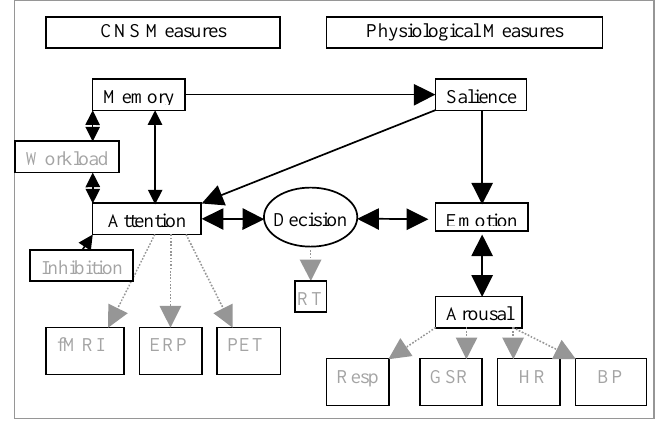
Fig. 1. Proposed relationship of the underlying theoretical constructs involved in the process of